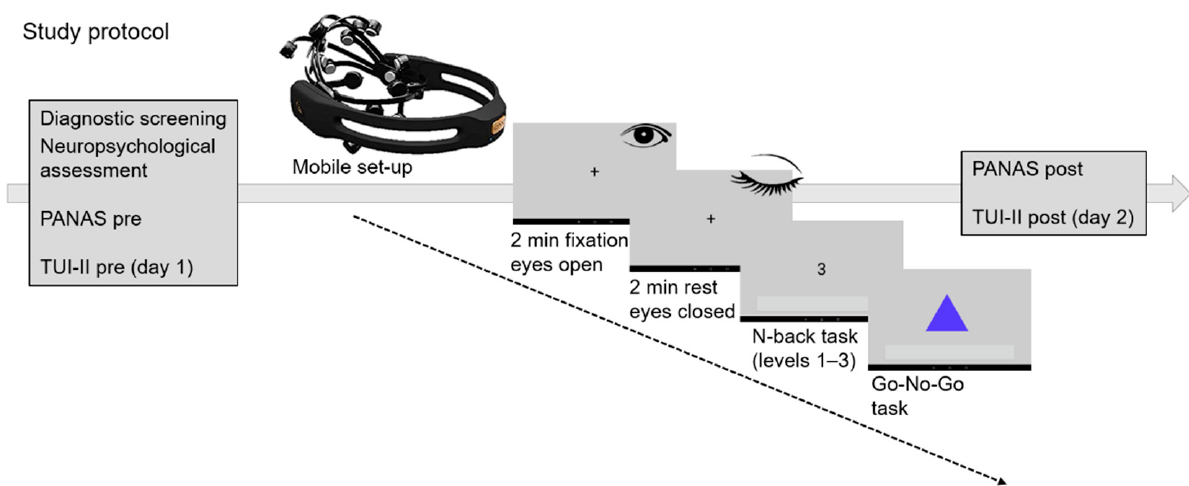
Figure 1. Study protocol. Participants completed two lab visits. On day 1 they received a diagnostic screening and neuropsychological assessment, and had to fill in the pre-assessment of the usability questionnaire. On day 1 and day 2, participants completed the PANAS to assess the affective state prior to and after the EEG recordings. Prior to the start of the cognitive tasks, participants received standardized instructions for the setup of the mobile EEG device. After successful application, a fixation cross was displayed and participants were instructed to keep eyes open, followed by two minutes of rest with eyes closed. Afterwards, participants completed the N-back task with three difficulty levels (presented in randomized order) and the Go/No-go task. On day 2 only, participants filled in the TUI-II-post questionnaire and the System Usability Scale after completion of the tasks.